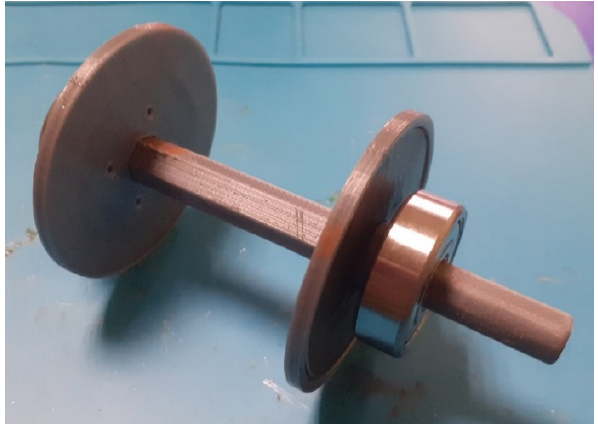
Figure 10. The stator of motor.